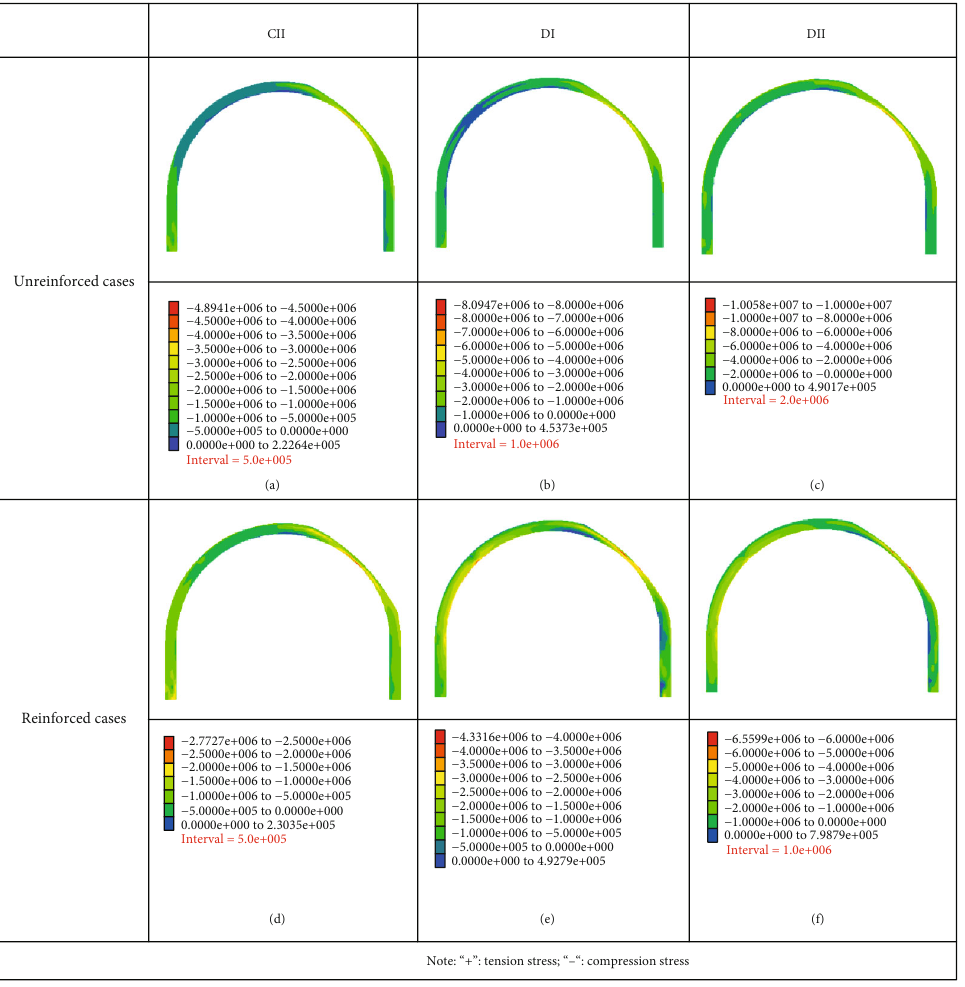
Figure 12: Axial stress distribution on lining concrete for tunnel with a cavity on the shoulder (unit: